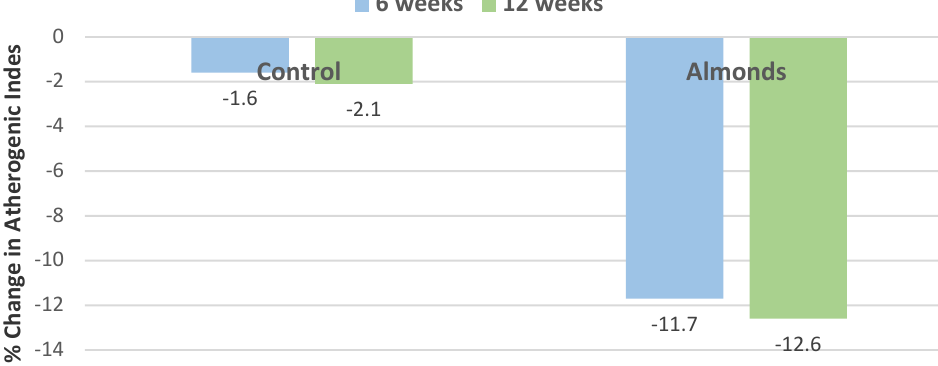
Figure 23. Effects of 10 g of almonds soaked overnight in water and consumed before breakfast on atherogenic index compared to no almond control ( p = 0.05) [37].